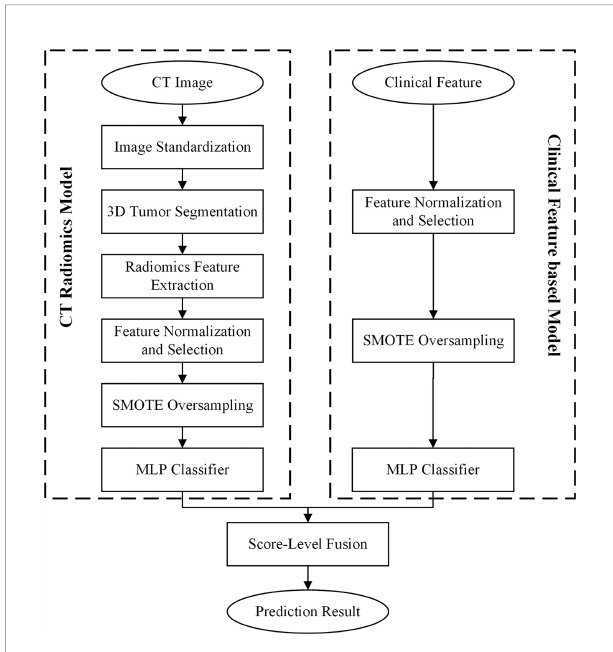
FIGURE 1 | The fl owchart of our proposed prediction